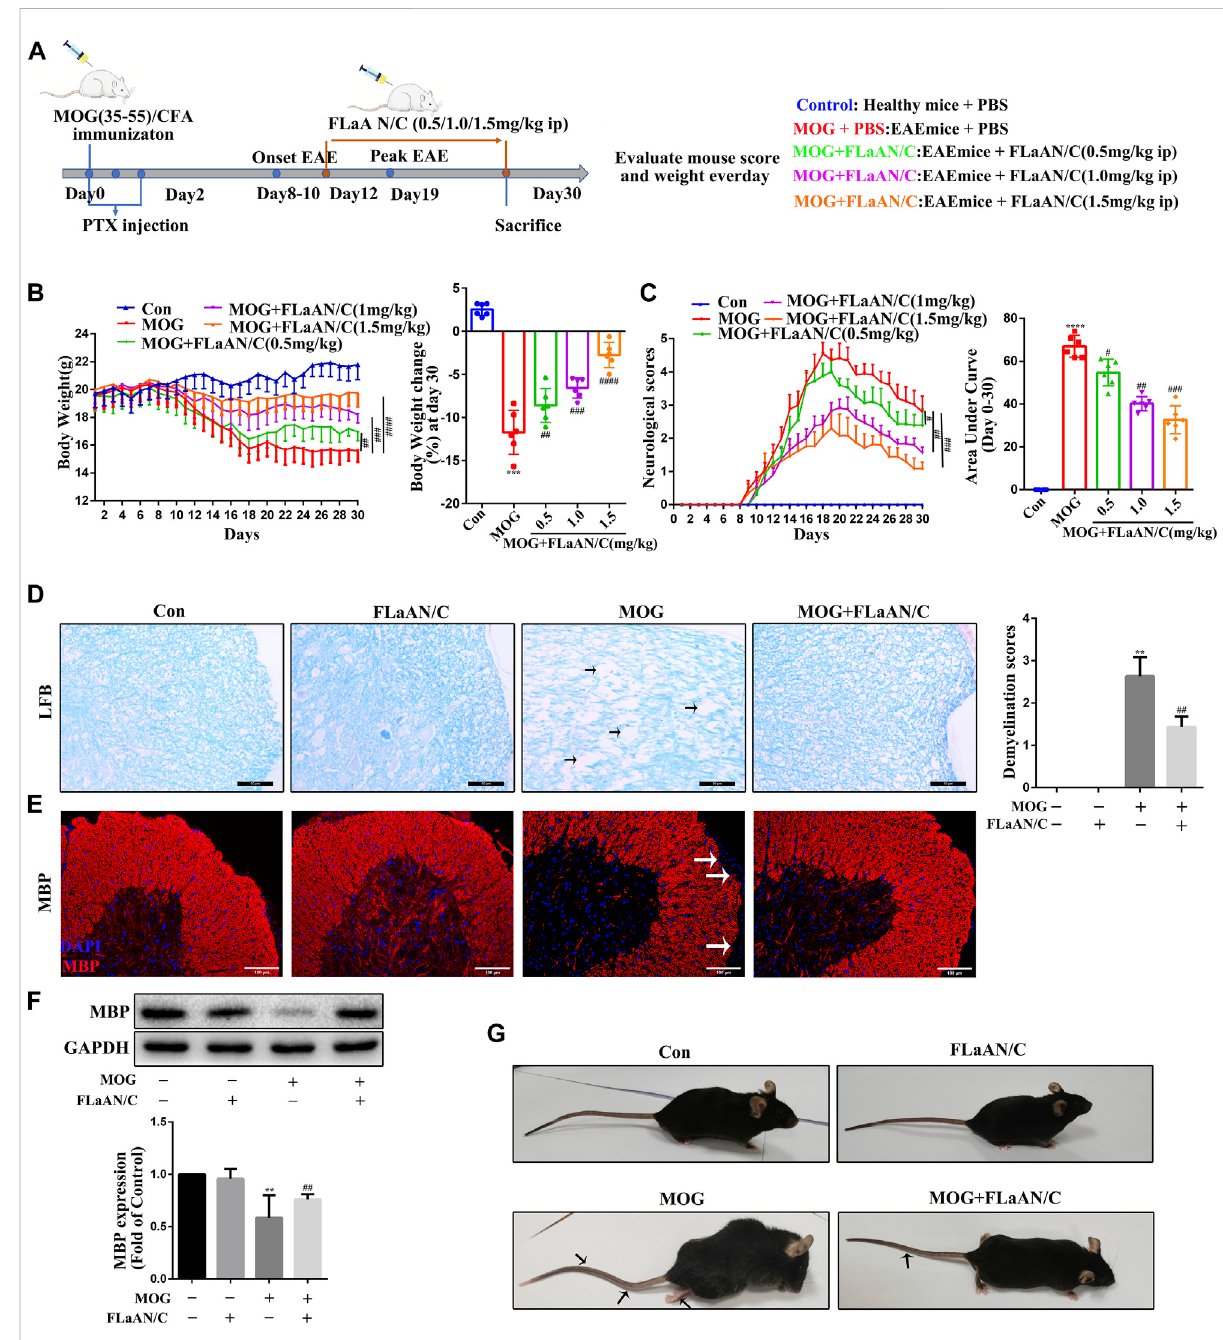
FIGURE 1 FLaAN/C reduces symptoms in EAE mice. (A) Study procedure. (B) Weight-versus-time curves of all experimental groups. (C) Clinical behavior scores for typical symptoms of EAE. (D) LFB staining showing demyelination in the spinal cord and the demyelination scores (The arrows present myelininjuryandloss,scalebars:50 μ m). (E) Immuno fl uorescencestainingofMBPinthespinalcord(Thearrowspresentmyelininjuryandloss,scale bars:100 μ m). (F) Western bloting of MBP protein expression of the spinal cord. (G) Representative images show behavioral symptoms of EAE mice in each group (Black arrows present limp tail or hind limb paralysis). Paraf fi n sections of spinal cord tissue used for immuno fl uorescence staining. Data are shown as means ± SD (n = 6 per group). * p < 0.05, ** p < 0.01, *** p < 0.001, **** p < 0.0001, # p < 0.05, ## p < 0.01, ### p < 0.001, #### p < 0.0001. * vs. Control group; # vs. MOG